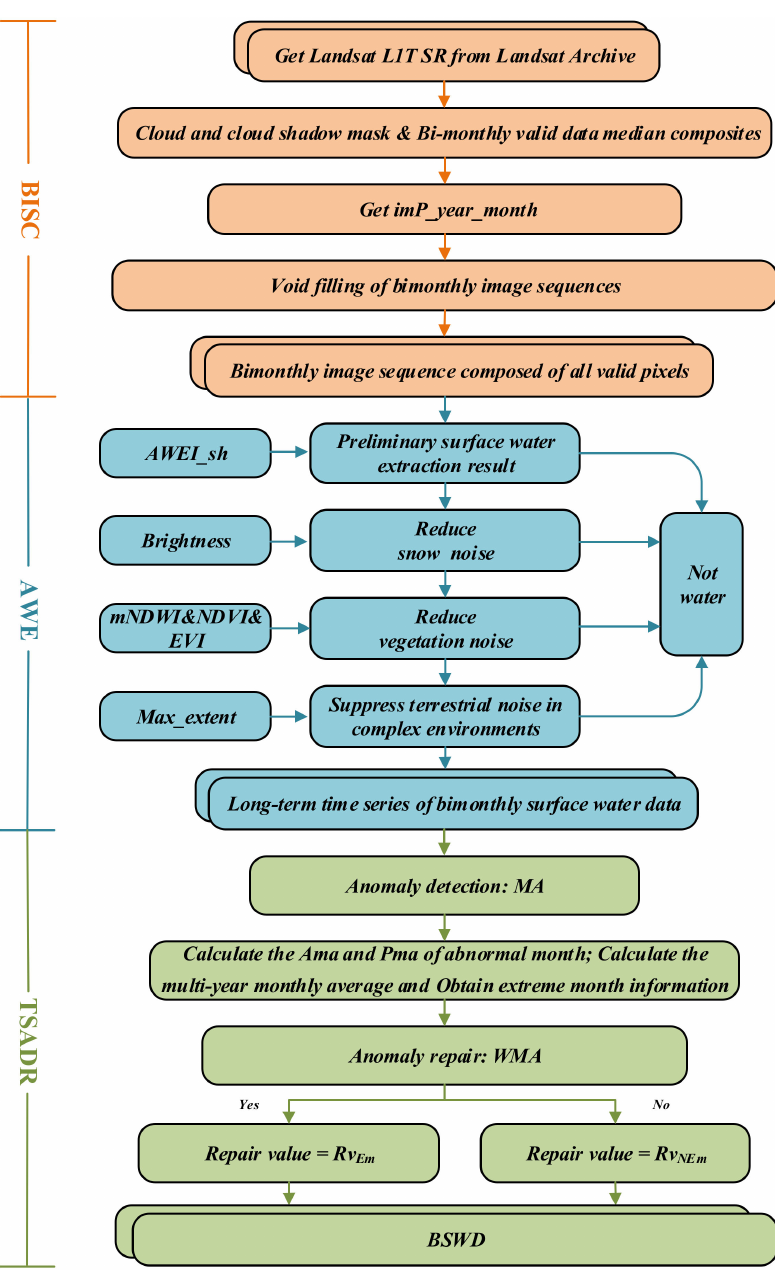
Figure 2. Flow chart for the construction of lake bimonthly surface water time series based on GEE and